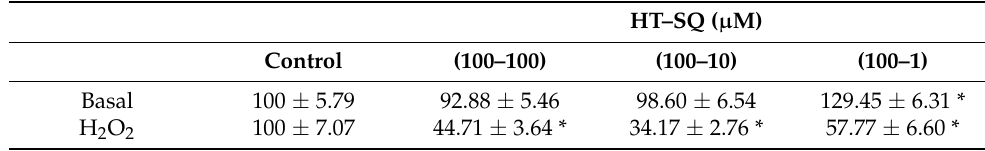
Table 4. DNA damage in MDA-MB-231 cells in basal state (blue) and with H 2 O 2 burst (orange) after treatment with HT at 100 µ M combined with SQ (100, 10 and 1 µ M) for 24 h followed by another 24 h with fresh